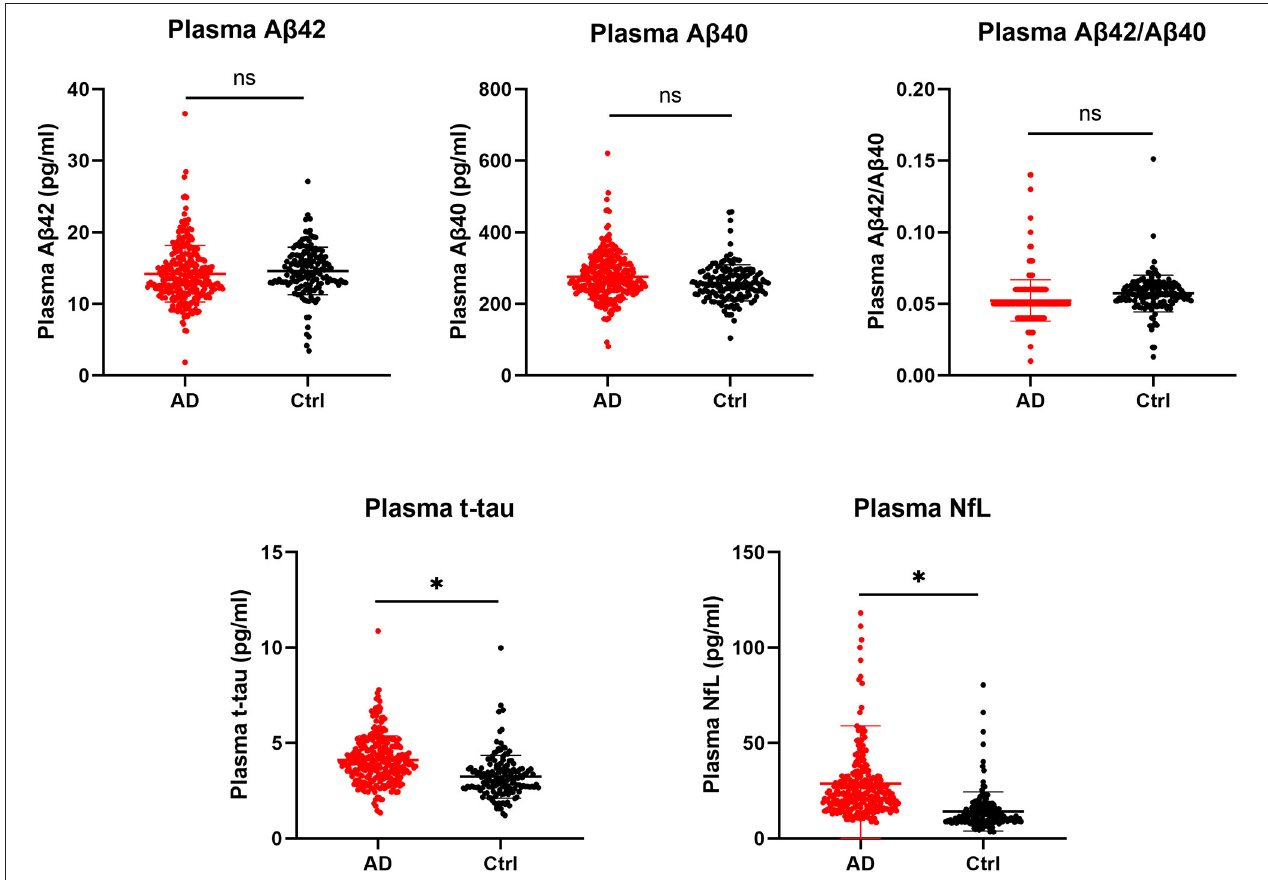
FIGURE 1 | Comparison of plasma biomarkers between the AD and CN groups. Plasma biomarkers are presented as the means ± SD. The significance of differences between groups was determined using the Mann-Whitney U test. AD, Alzheimer’s disease; CN, cognitively normal; t-tau, total tau; NfL, neurofilament light chain; ns, not significant; * p <